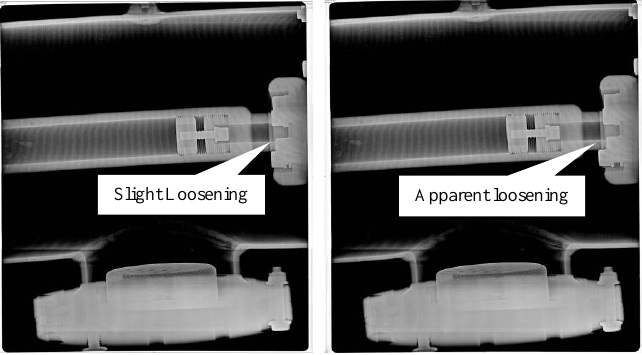
Figure 20. The obviously loosened metal screws in the grading shield with partial discharge.